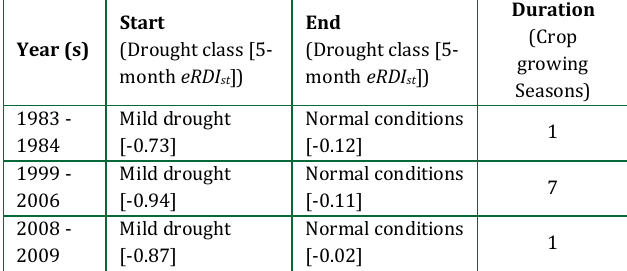
Table 3: Duration of agricultural drought Events in terms on annual crop growing seasons i.e. annually and the severity level at which the agricultural drought commenced.